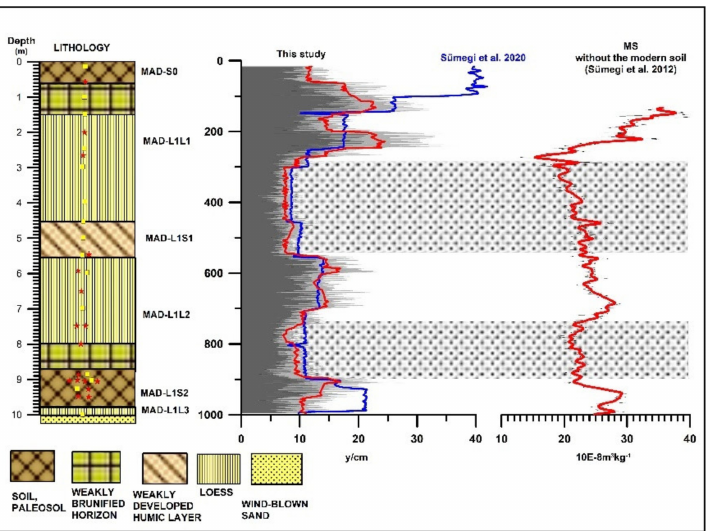
Figure 9. Sedimentation times (inverse AR in y/cm) calculated for 14 C Model 1 (Sümegi et al., 2020) [5] and Model 2 (this study) and magnetic susceptibility data from Sümegi et al. (2012) [6]. Note: solid lines on sedimentation times correspond to average model values, gray shading represents 95% CI of the models, gray bands depict areas of reduced sedimentation times and parallel decreasing trend in and/or reduced magnetic susceptibility